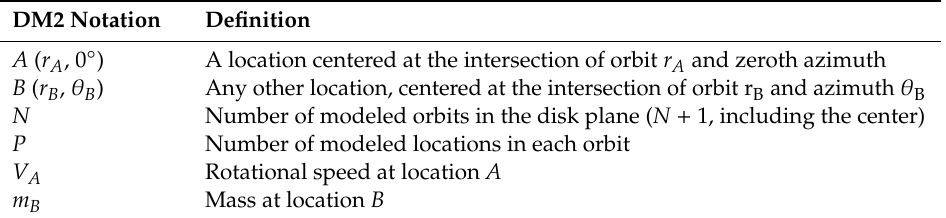
Table A1. Notations used in DM2 model